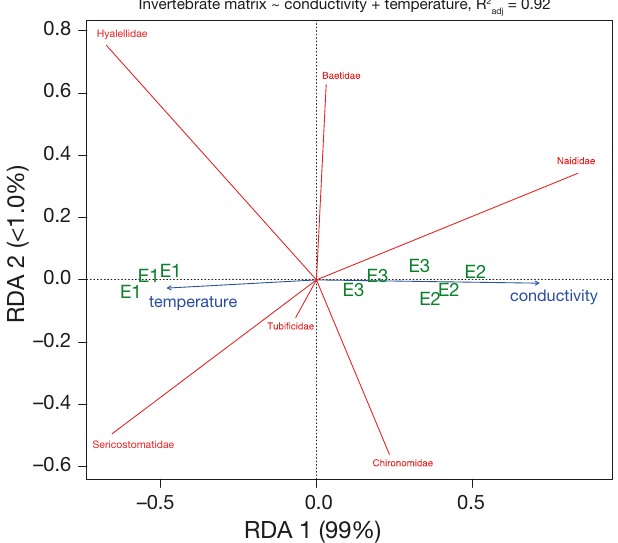
Fig. 2. Redundancy analysis (RDA) exploring the effect of environmental factors on macroinvertebrate communities across sites both upstream (E1) and downstream (E2, E3) from the fish-farm effluent discharge